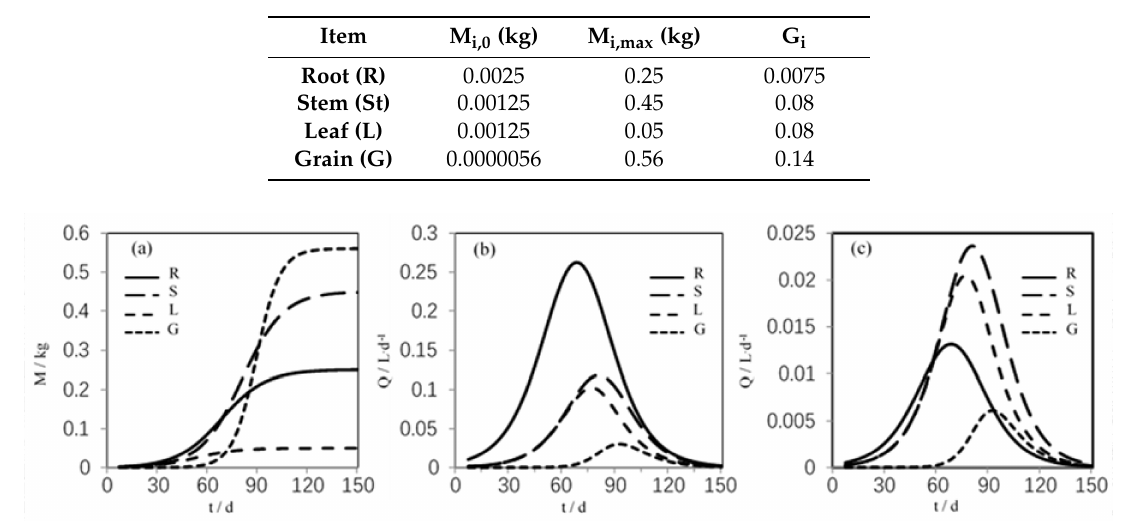
Table 3. Initial mass, maximum mass and growth rate in each wheat part.